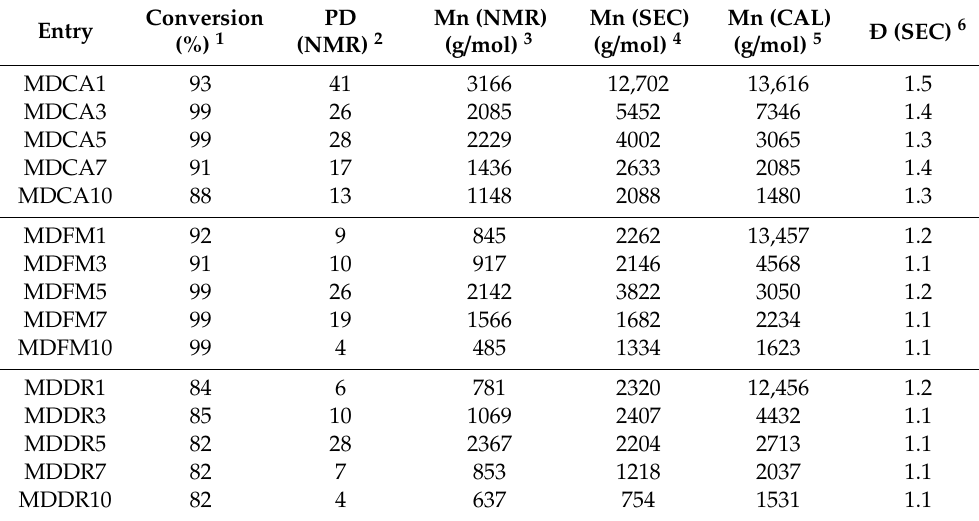
Table 1. Conversion of L-lactide to Macromolecular Dyes (MDs), polymerization degree (PD), number average molecular weight (Mn) determined by proton nuclear magnetic resonance 1 H-NMR and by size exclusion chromatography (SEC), Mn calculated on the basis of L-lactide / initiator in the feed, and dispersity (Ð = Mw / Mn) determined by